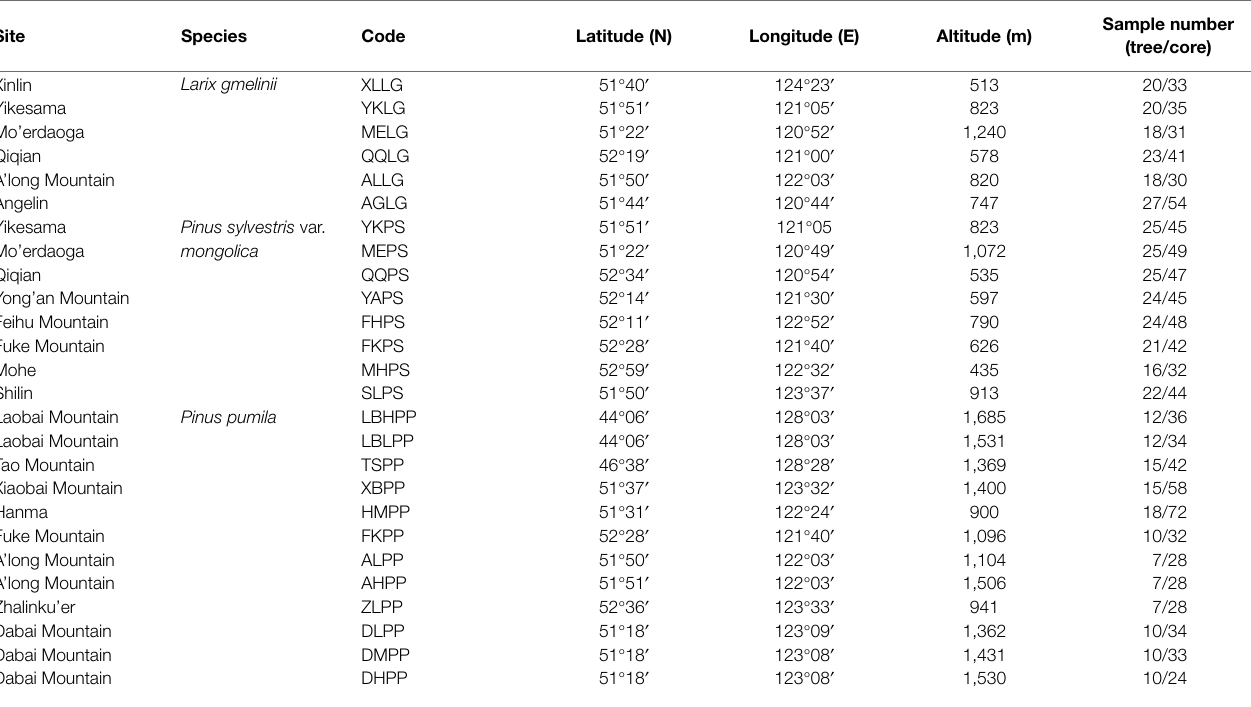
TABLE 1 | Information on the 26 sample sites in the northeast of